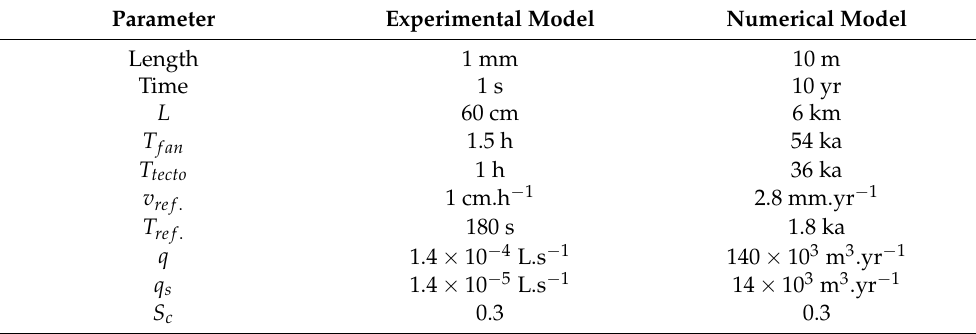
Figure 2. Main geometric and tectonic model set-up. ( a ) General scheme of the device. The coordinate system is centered in the middle of the fault, given by the red line. The closed box boundaries are represented with hatching lines. Input flux is represented with two arrows: a blue arrow for the total flux (water and sediments) and an orange arrow for sedimentary flux only. ( b ) Close-up on the fault zone. The topography is represented with an orange line. α is the fault angle and the red arrow the fault slip direction V tecto . ( c ) Temporal evolution of the fault displacement, including a fan building stage with no tectonics and a tectonic forcing stage. Two slip modes are modeled: stable sliding and stick-slip behavior. i represents the increment of displacement per earthquake and T the interseismic duration. Table 1. Scaling parameters between experimental and numerical reference